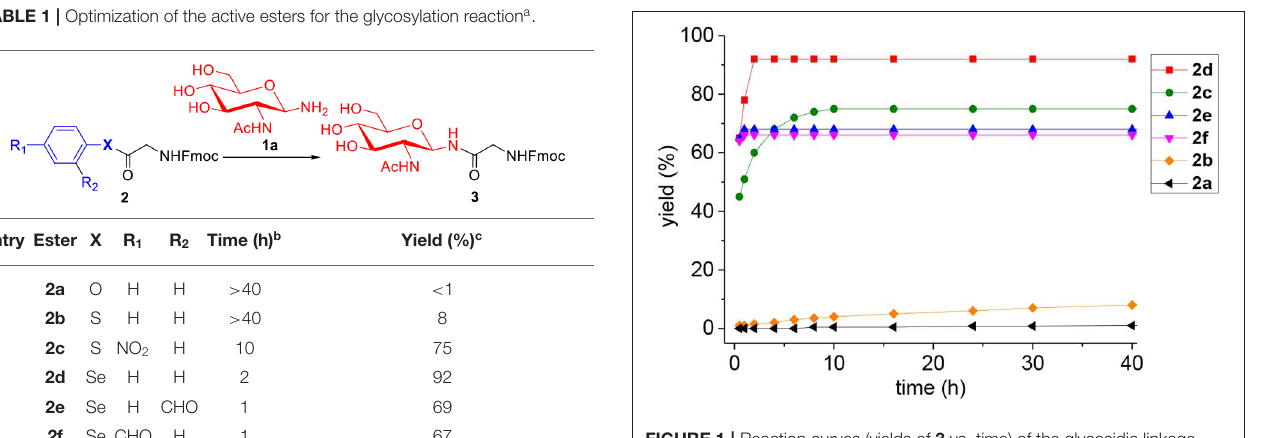
FIGURE 1 | Reaction curves (yields of 3 vs. time) of the glycosidic linkage formation between 2a − 2f and 1a .